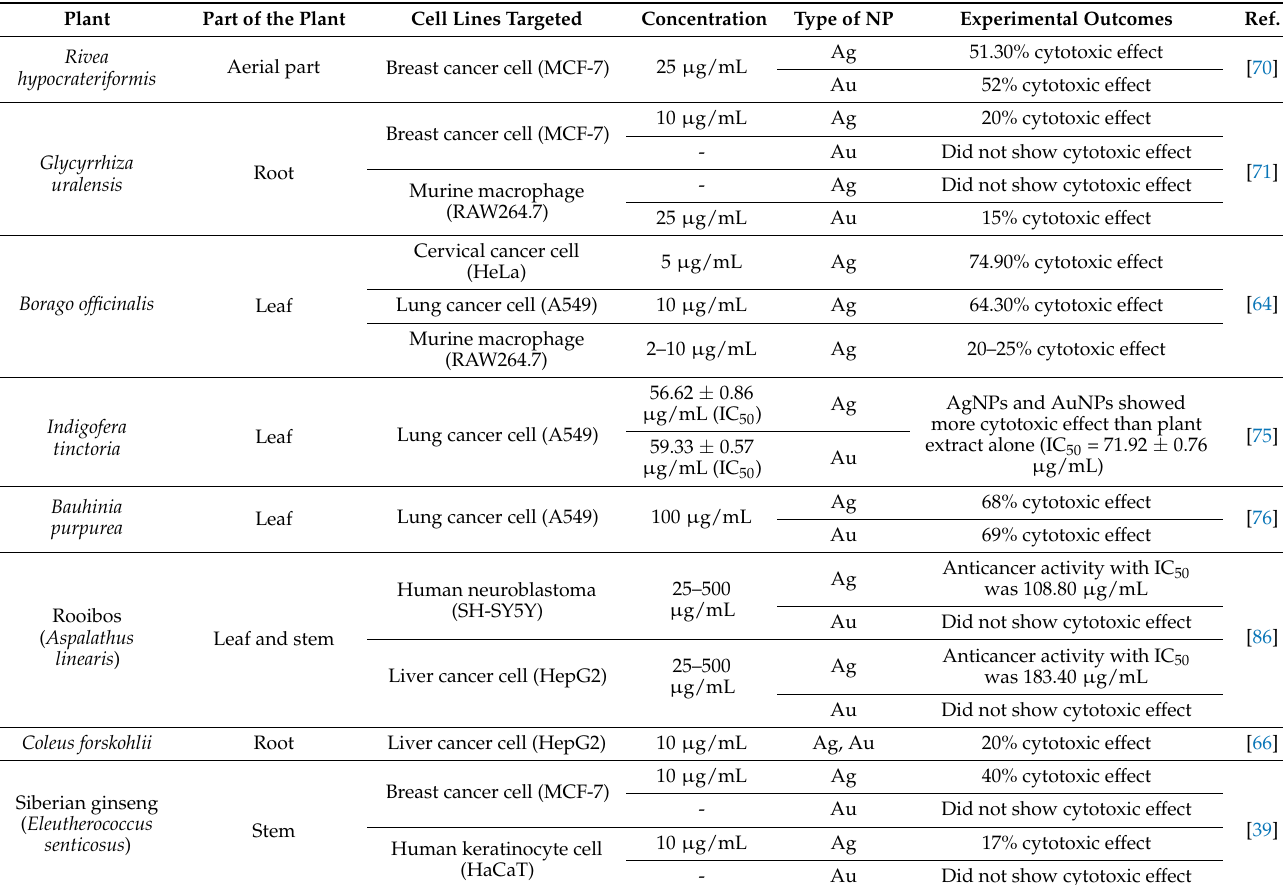
Table 3. Plant-based gold and silver nanoparticles as anticancer